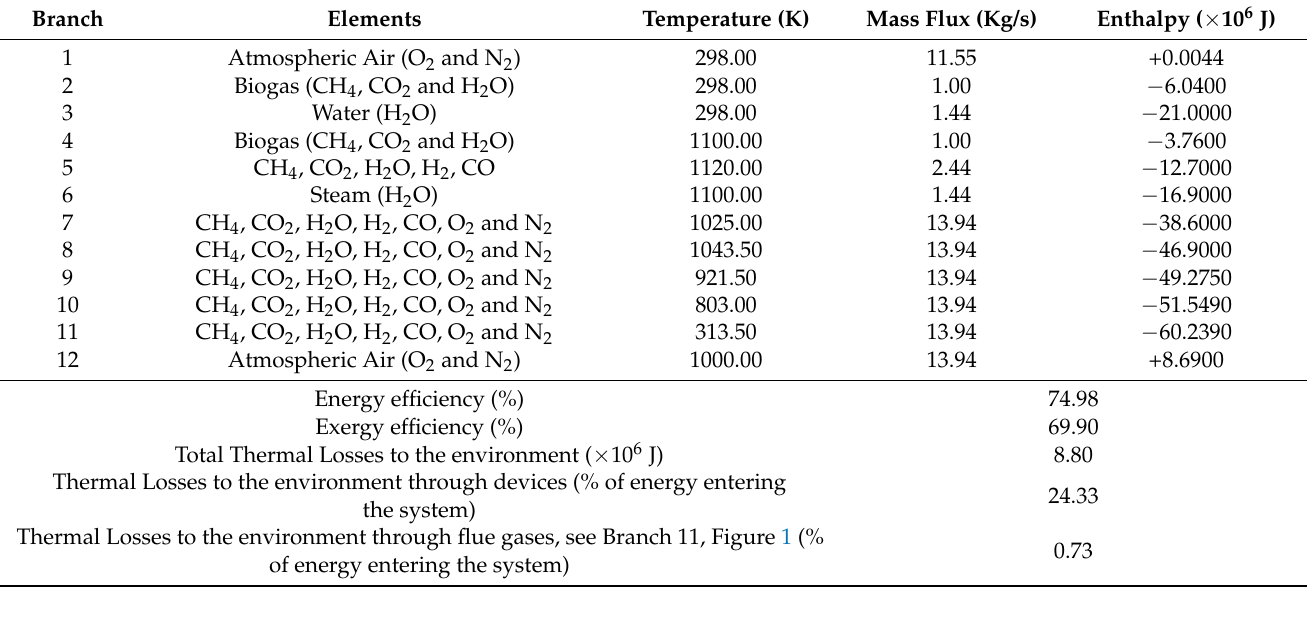
Table 2. Typical results for the optimized system, λ =2.5.